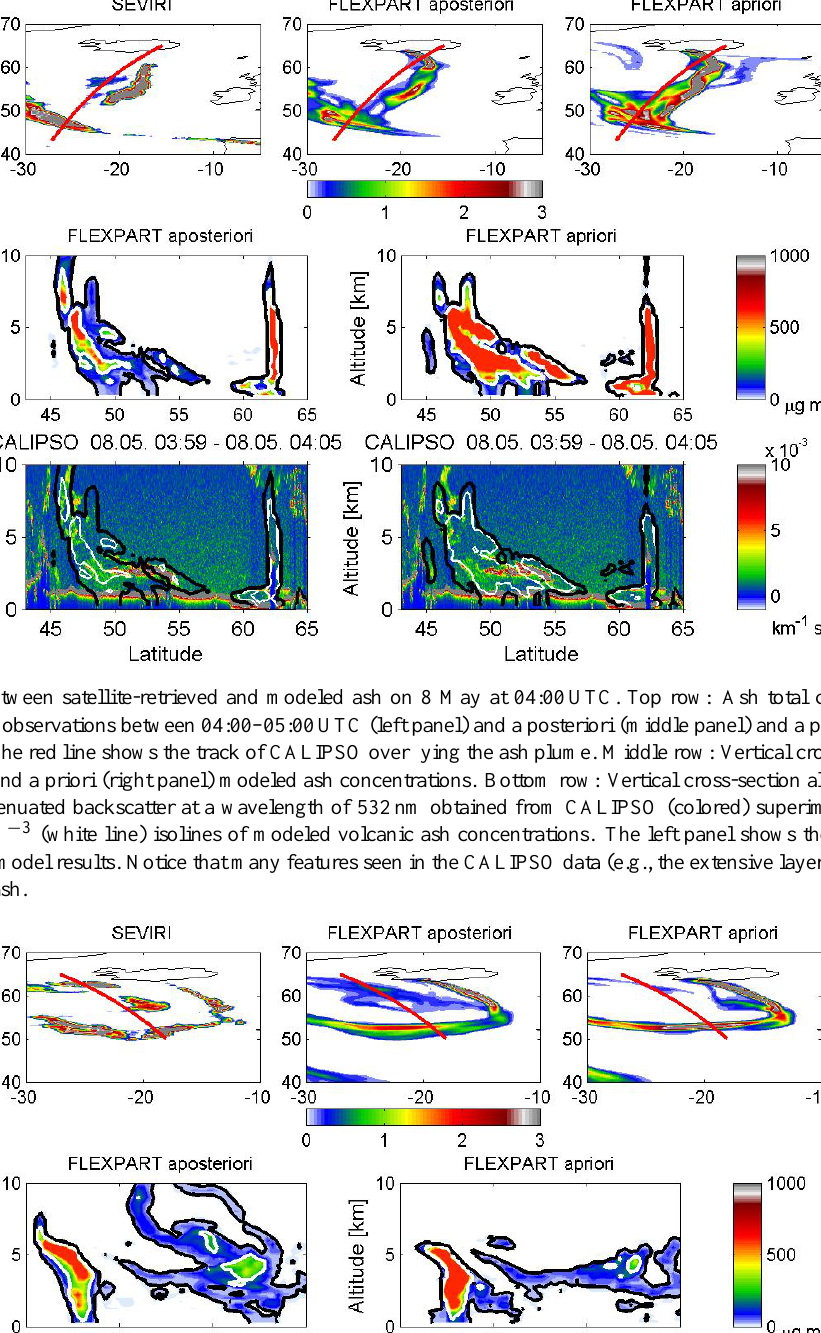
Fig. A2. Same as Fig. A1, but for 9 May at 14 UTC.